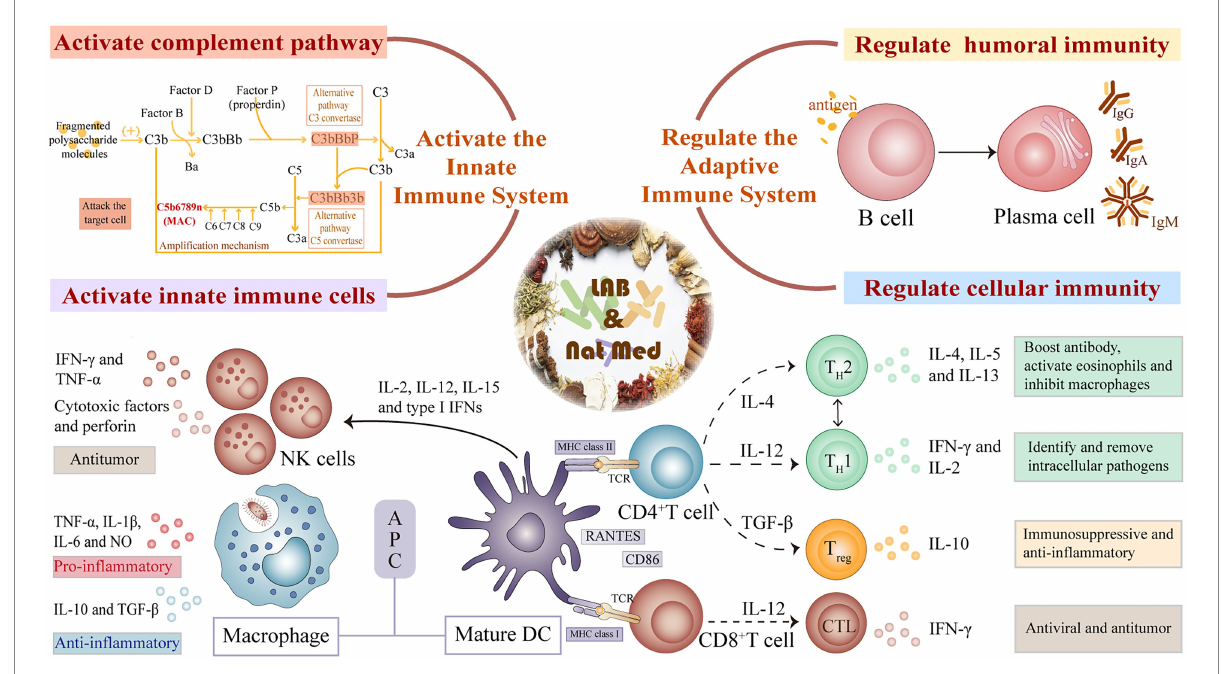
FIGURE 2 Mechanism of innate and adaptive immunity regulation of natural medicines fermented by lactic acid